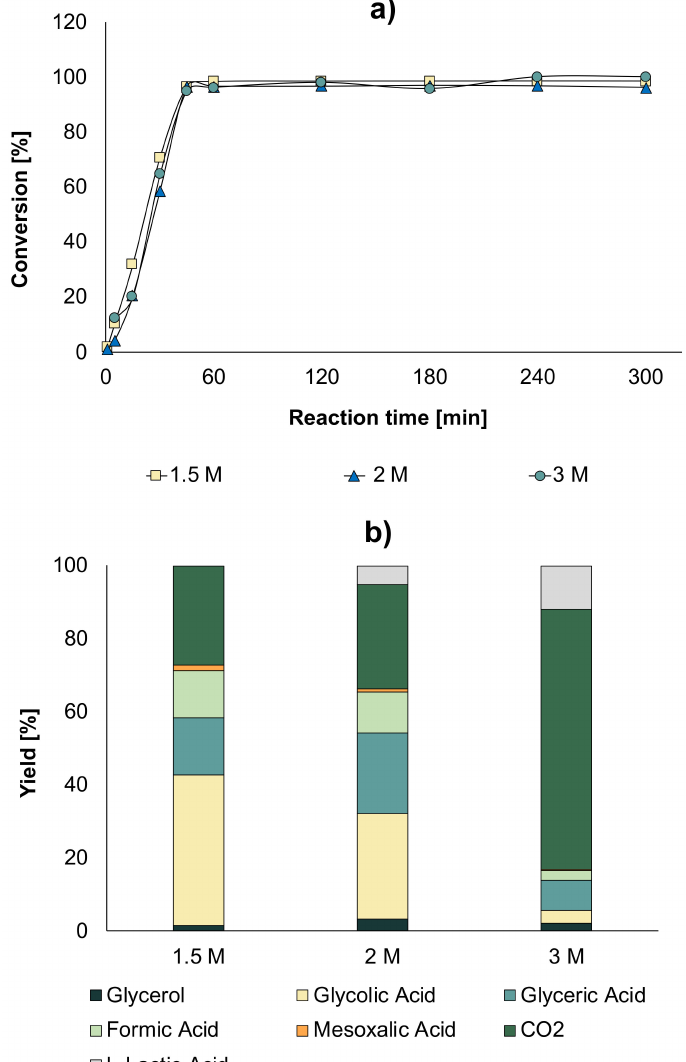
Figure 11. Surface response for the glycolic acid yield evaluated against the most influential variables, namely the O 2 /glycerol molar ratio and the catalyst/glycerol mass ratio.